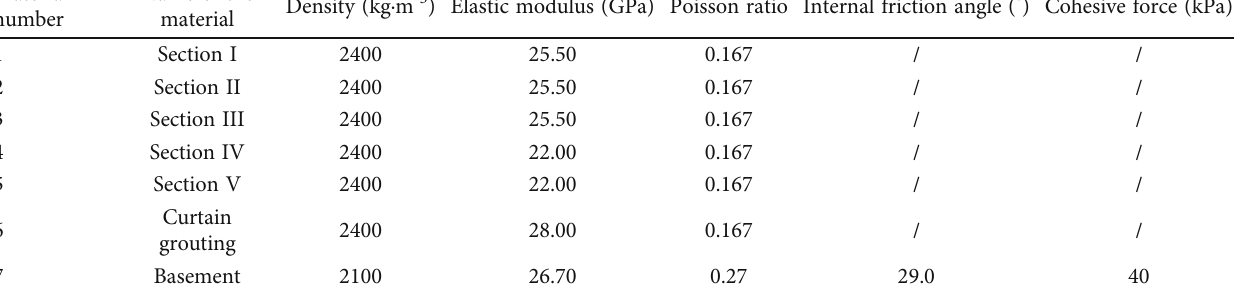
Table 1: Concrete material parameters.